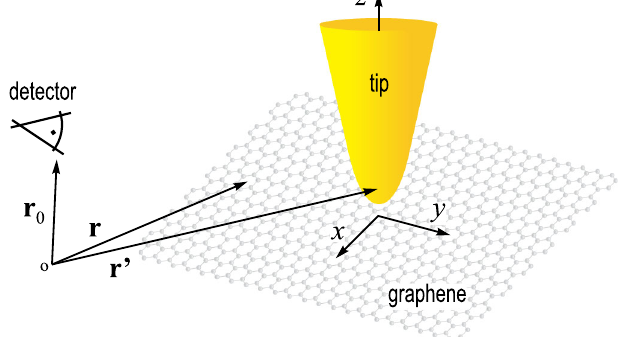
FIG. 2. Illustration of spatially resolved near-field Raman scattering of a graphene sample. The electric field E confined to the apex of a laser-irradiated gold tip interacts locally with the graphene lattice characterized by the Raman polarizability α where γ denotes a specific phonon mode ( γ ∈ ½ G ; D ; G 0 (cid:3)Þ